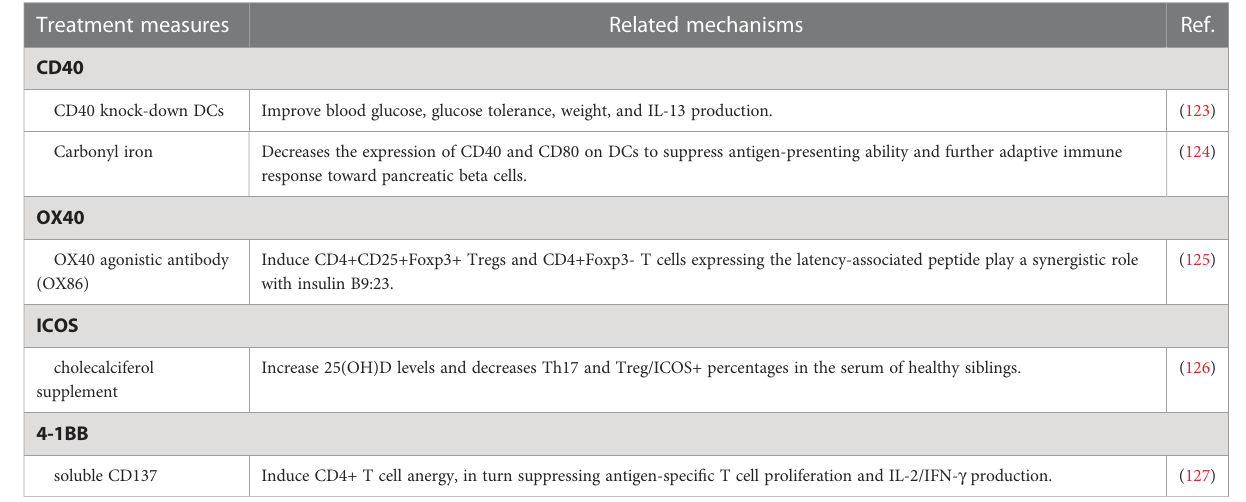
TABLE 2 The roles of treatment measures regulating co-stimulatory molecules for T1D. Treatment measures Related mechanisms